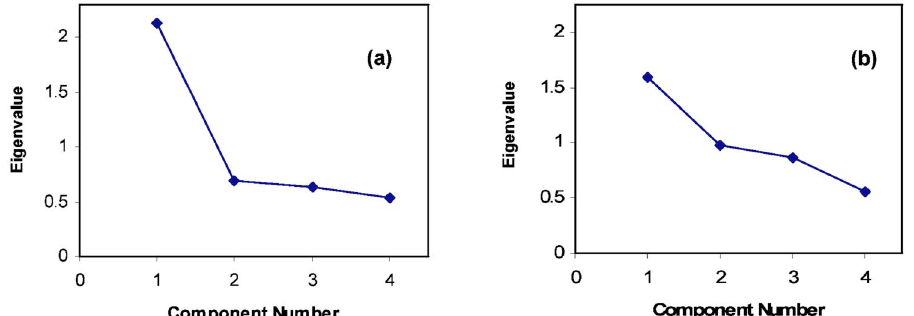
FIG. 2. (cid:1) Color (cid:2) Scree plots of a good category (cid:1) a (cid:2) and a poor category (cid:1) b (cid:2)